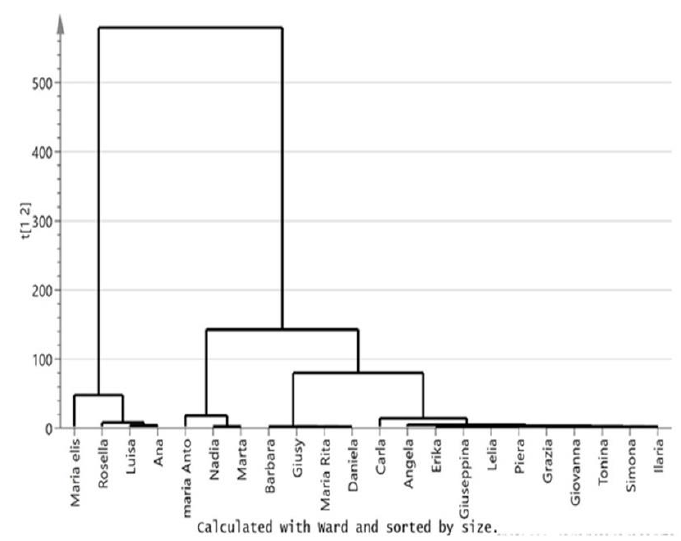
Figure 6. Hierarchal cluster analysis using climatic data sites of origin of cultivars and total phenols, anthocyanins, and tannins content of myrtle berries.